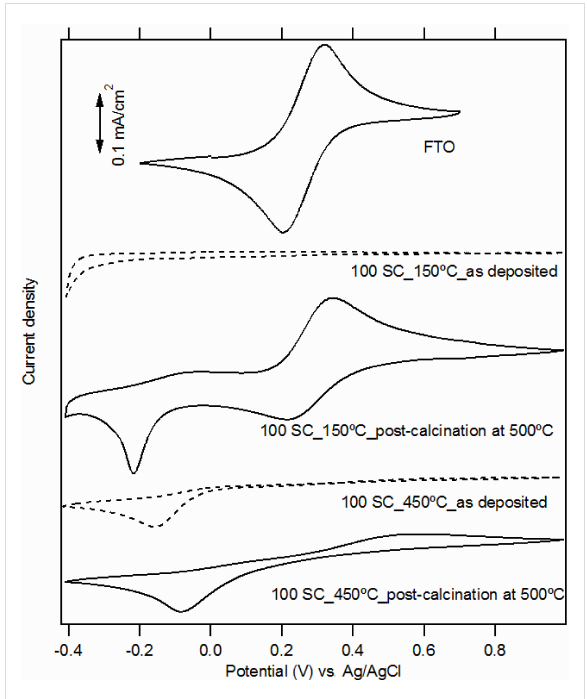
Figure 2: Cyclic voltammograms on an uncoated FTO(A) electrode and one covered by TiO 2 films consisting of 100 SCs of TAA (0.05 M). Scan rate 50 mV/s. Electrolyte solution was 0.5 mM Fe(CN) 63 − /4 − in aqueous 0.5 M KCl, pH 2.5. The voltammograms (except for FTO) are offset for clarity but the current density scale is identical for all